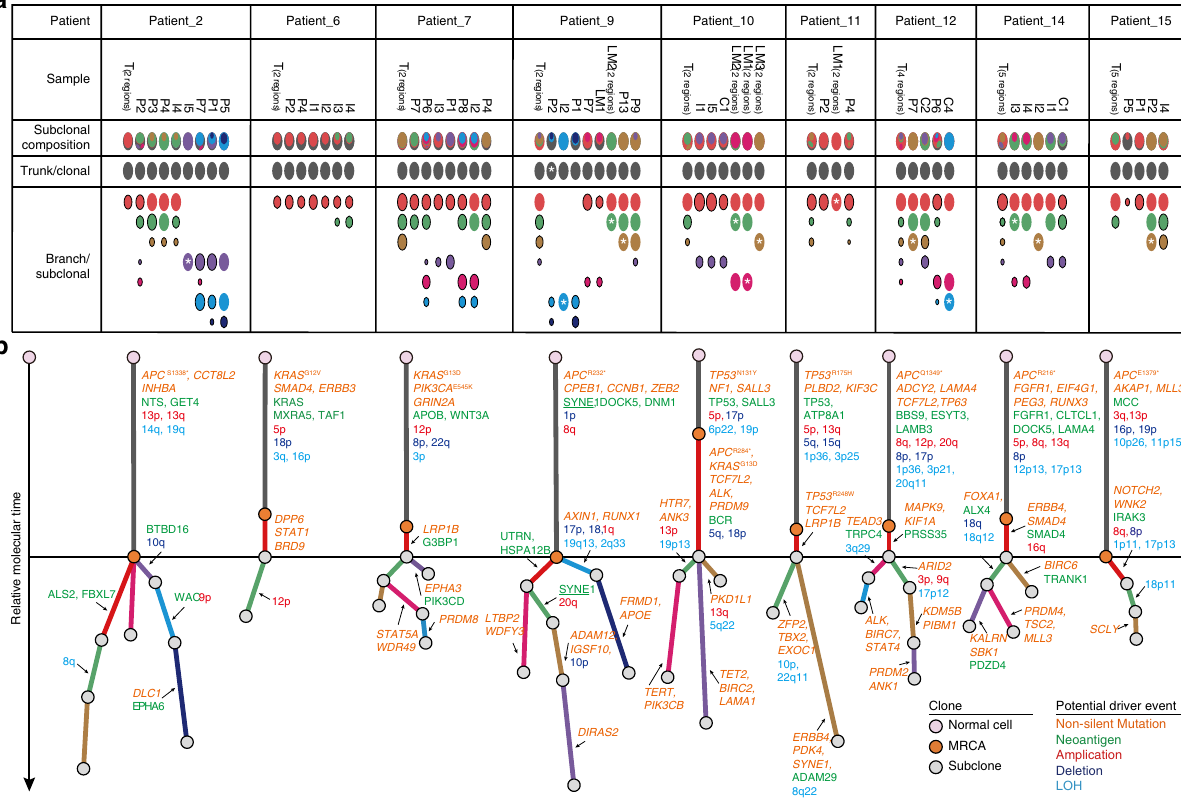
Fig. 4 Clonal structures of 9 CRC cases. a Oval plots for 9 CRC cases. Clones and subclones are denoted as in Fig. 3. b Phylogenetic trees were constructed from the subclonal structure of each patient. The trees were rescaled to fi t the plot and are denoted as in Fig. 3b. Detailed genomic events of each patient are shown in Supplementary Figs. 3 –